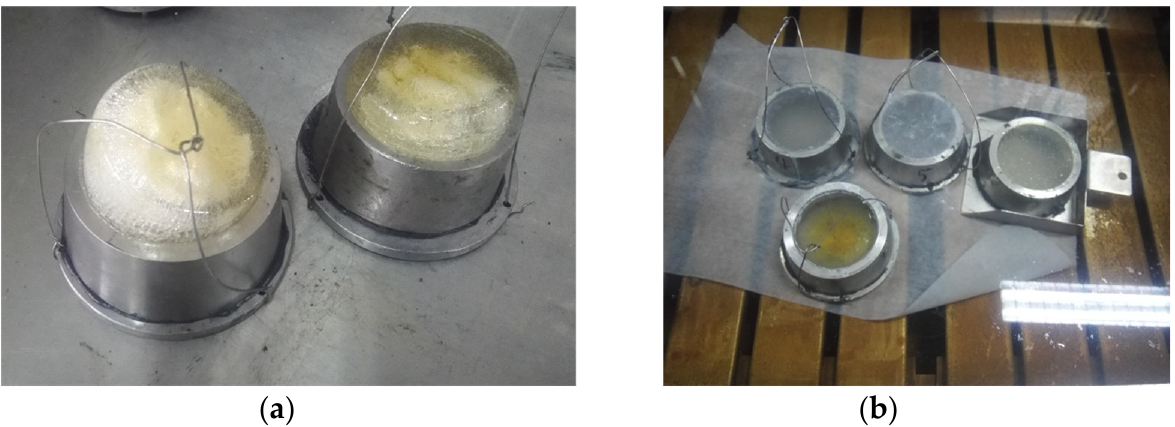
Figure 14. ( a ) Unstable polymerization of conventional epoxy resins. ( b ) Stable curing of the modified sealants.